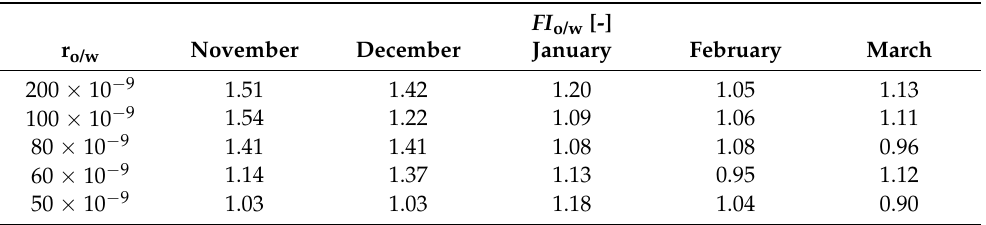
Table 10. FI o/w for seawater polluted by a mixture of oils for various r o/w for November,